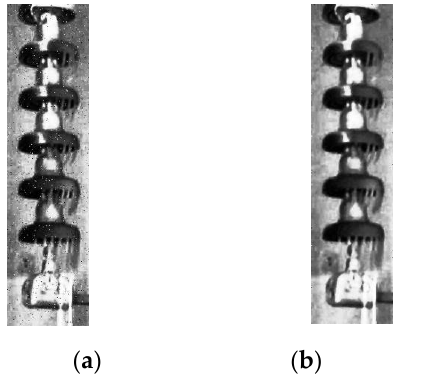
Figure 3. The grayscale image and the image after direct equalization and its histogram of grayscale distribution. ( a ) Original grayscale image and its histogram. ( b ) Grayscale image and its histogram after direct equalization.